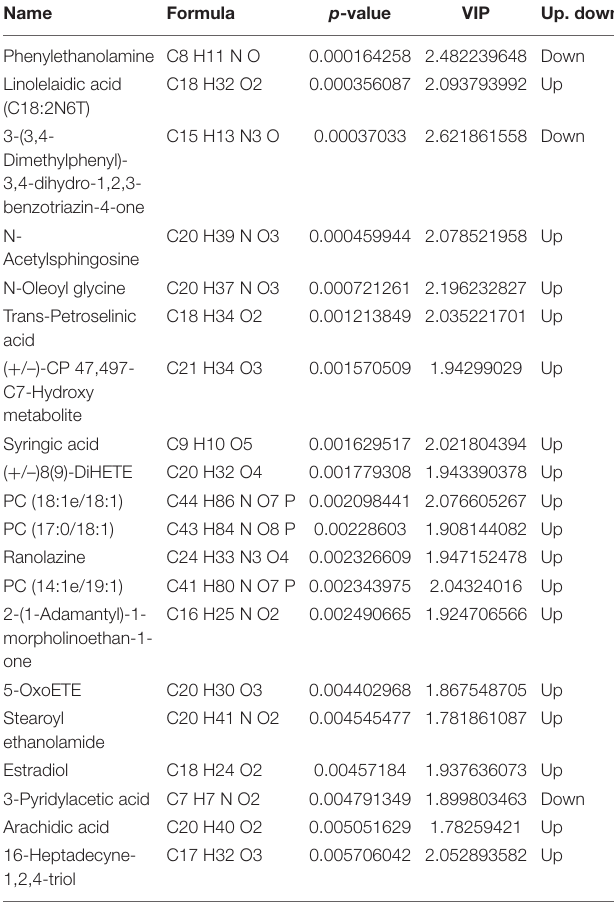
TABLE 2 | The top 20 differential metabolites.